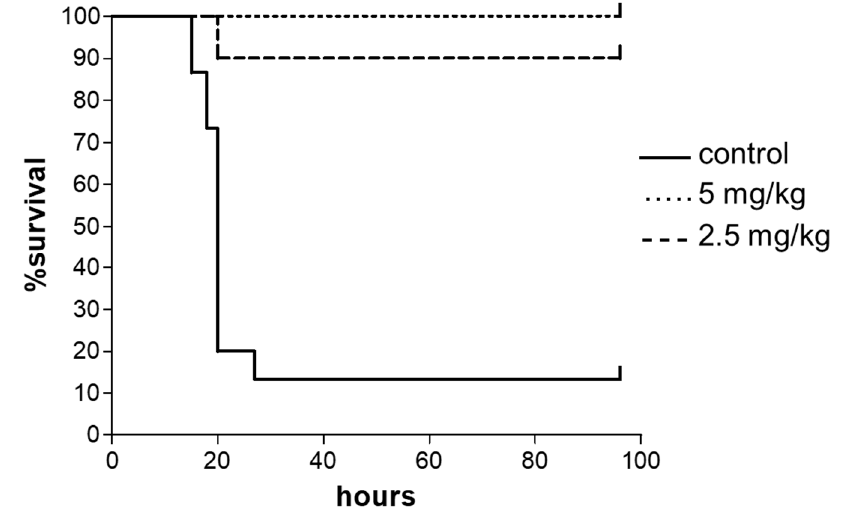
Figure 2. In vivo antibacterial activity of SET-M33D peptide. A total of 10 BALB-c mice / group (20 g) were injected i.p. with a lethal amount of S. aureus USA 300 (1 × 10 6 CFU / mouse) and treated with SET-M33D 30 min, 3 and 6 h post-infection. Continuous line (control), injection with bacteria and treatment only with vehicle; dashed line, injection with bacteria and treatment with three injections of SET-M33D 5 mg / kg; dotted line, injection with bacteria and treatment with three injections of SET-M33D 2.5 mg / kg. *** p < 0.0001 Log-rank (Mantel-Cox) test; n = 10.